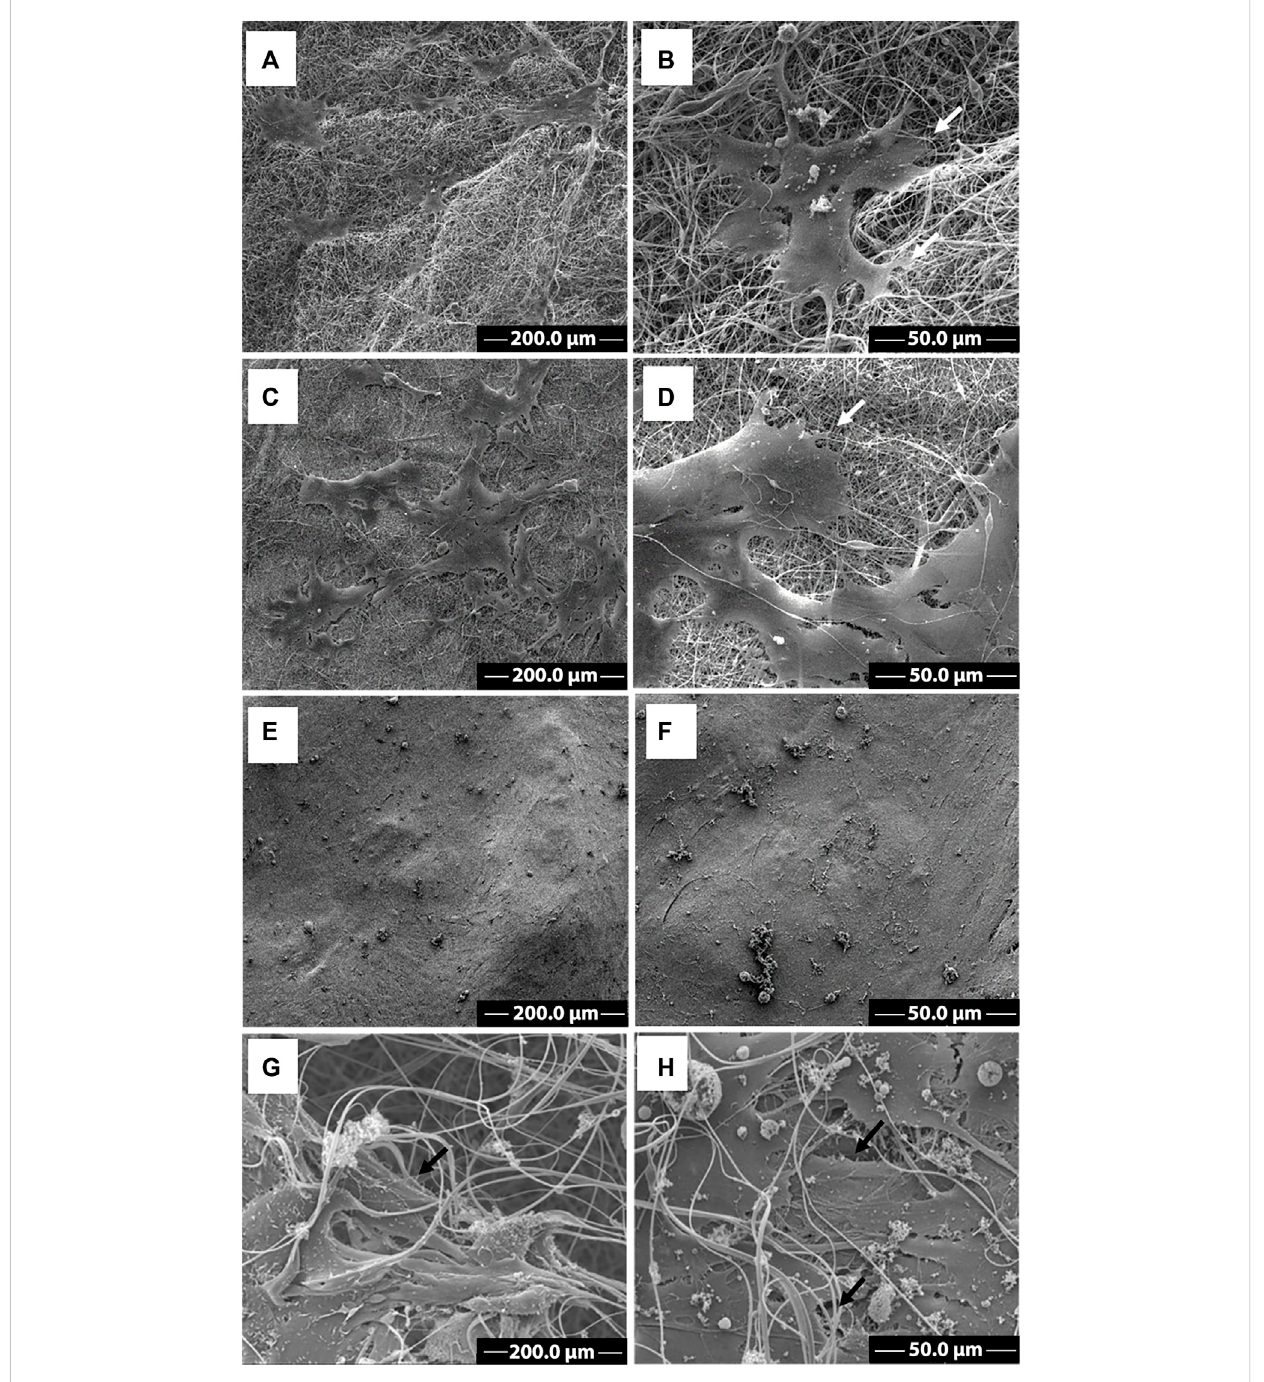
FIGURE 5 SEM images of C2C12 cells growth on CA and CA@A nano fi bers. SEM images at different magni fi cations of C2C12 cells cultivated onto cellulose acetate nano fi ber (A, B) and cellulose acetate nano fi ber with annatto extract (C, D) after 2 days. SEM images at different magni fi cations of C2C12 cells cultivated onto cellulose acetate nano fi ber (E, F) and cellulose acetate nano fi ber with annatto extract (G, H) after 7 days. Scale bars indicate (A,C,E, G) 200 µm and (B,D,F, H) 50 µm. White arrows indicate cell-nano fi ber adhesion